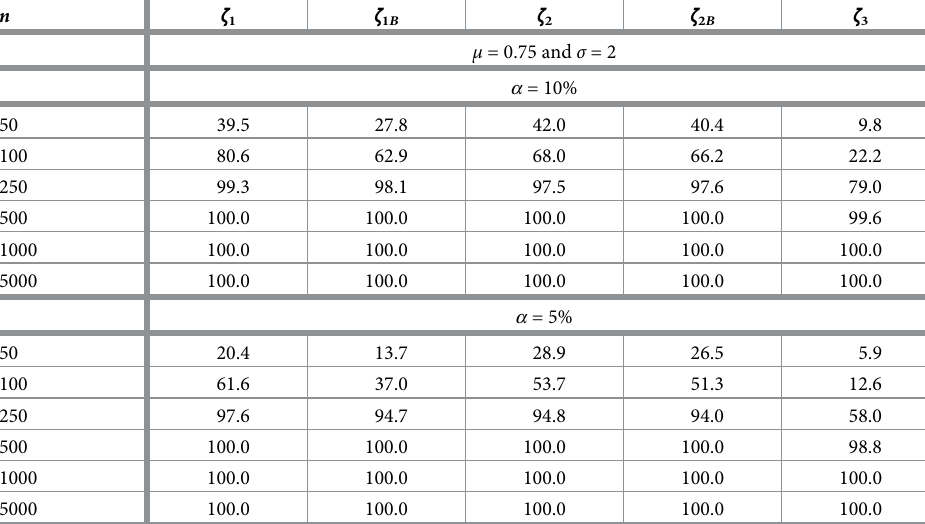
Table 6. Non-null rejection rates (%), data generated from S ð μ ; σ Þ .